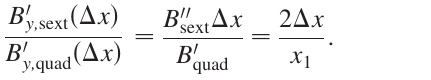
PSM at the PF ring are x 1 ¼ 15 mm and (cid:1) x ¼ 0 : 7 mm , the stored beam becomes 95% smaller than that of the PQM; and the field gradient becomes 90% smaller.